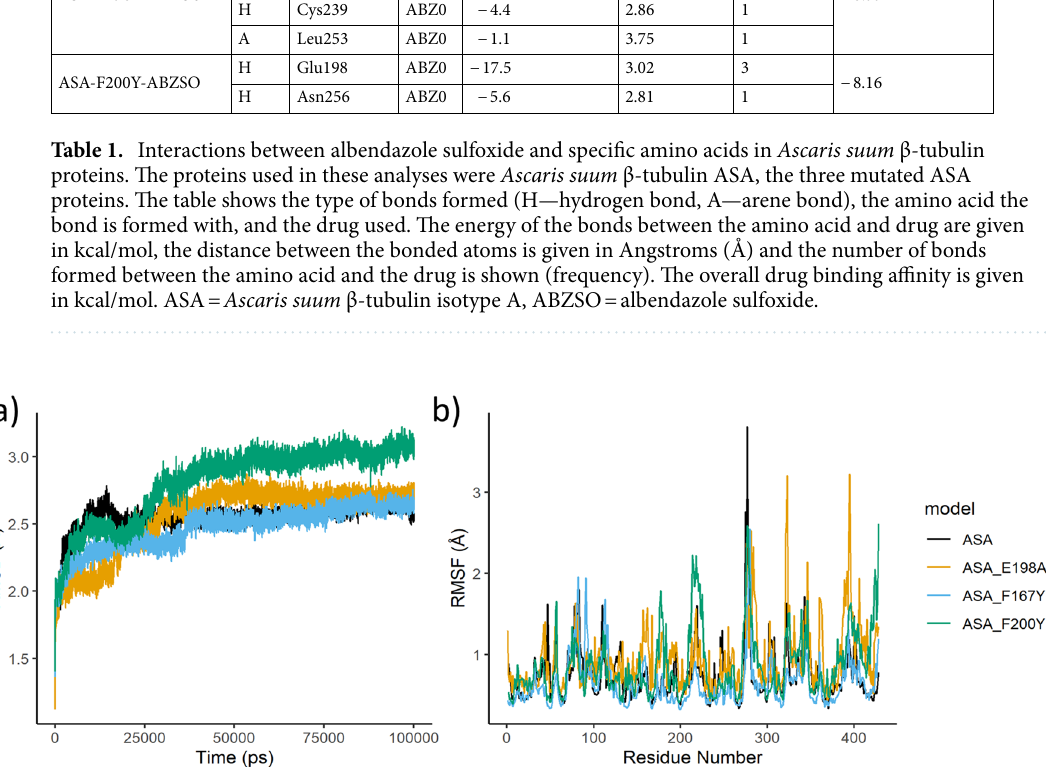
Figure 5. Root-mean-square deviation (RMSD) and root-mean-square fluctuation (RMSF) analysis of molecular dynamics simulations. The graphs show ( a ) the RMSD and ( b ) the RMSF of each of the structures throughout the molecular dynamics simulations. The RMSD shows that after the initial burn-in the structures are equilibrated and stable, as indicated by the consistency of the RMSD values. The RMSF values show how much each amino acid fluctuates through the simulations and highlights those that fluctuate the most. The wild- type model is shown in black, the F167Y model is shown in orange, the E198A model is shown in blue and the F200Y model is in